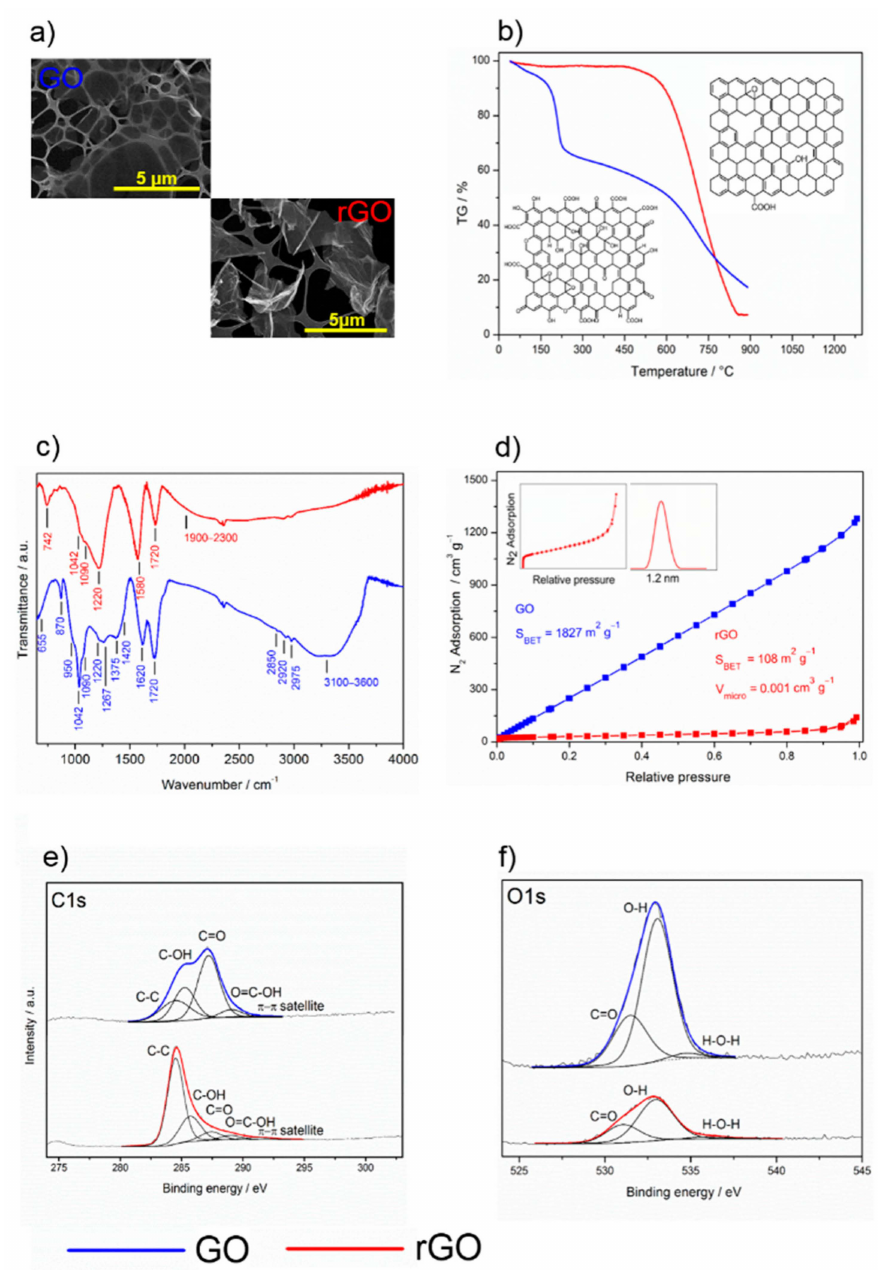
Figure 1. Physicochemical properties of graphene oxide (GO, blue) and reduced graphene oxide (rGO, red). ( a ) SEM images, ( b ) TGA curves, ( c ) FT-IR spectra, ( d ) physical sorption of nitrogen, ( e ) C1s, and ( f ) O1s XPS